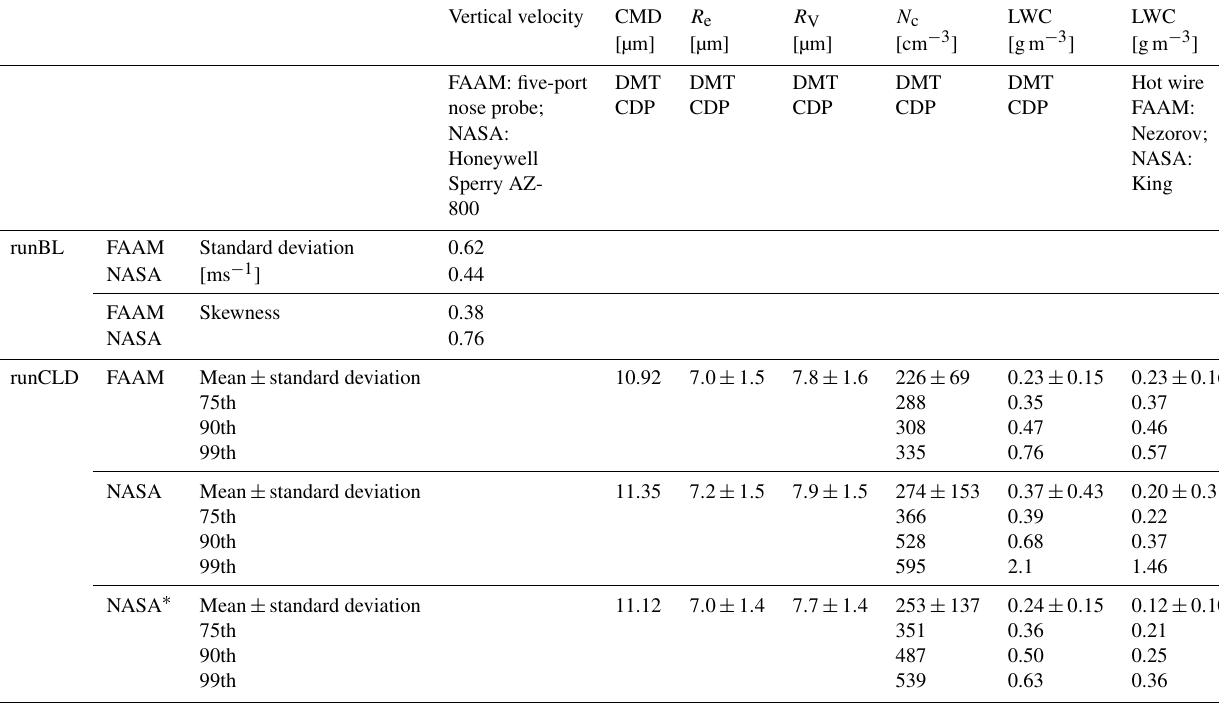
Table 6. Cloud microphysical and bulk properties; mean and standard deviations; 75th, 90th and 95th percentiles; and boundary layer turbulence.